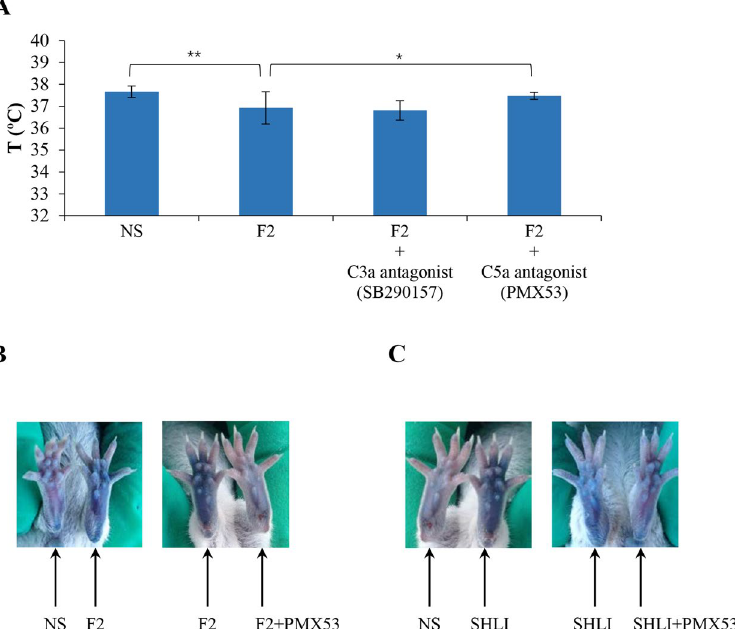
Figure 5. SHLI-induced NA-IHRs is mediated by C5a. ( A ) C5a antagonist PMX53 can block F2-induced shock (n = 10). The mice were pretreated with propranolol (i.v., 35 μ g/mouse) 10 min after intraperitoneally injected with SB290157 (a C3a antagonist, 30 mg/kg) or PMX53 (a C5a antagonist, 1 mg/kg). Twenty minutes later, the mice were challenged (i.p.) with F2 (16.5 mg/mouse). Thirty minutes later, the rectal temperature was measured. * P < 0.05 and ** P < 0.01. ( B ) Representative images of Evans Blue extravasation of mouse paw induced by F2 and blocked by PMX53 (n = 6). Fifteen minutes after induction of anesthesia (50 mg/kg of pentobarbital), mice were intraplantarly injected with 10 μ L of PMX53 (1 mg/mL). Twenty minutes later, the mice were injected (i.v.) with 50 μ L of 12.5 mg/mL Evans Blue. Five minutes later, 5 μ L of F2 (33 mg/mL), or NS was administered by intraplantar injection in the paw. Thirty minutes later, the mice were sacrificed and the paws were photographed. ( C ) Representative images of Evans Blue extravasation of mouse paw induced by SHLI (10 μ L/ paw) and blocked by PMX53 (n =